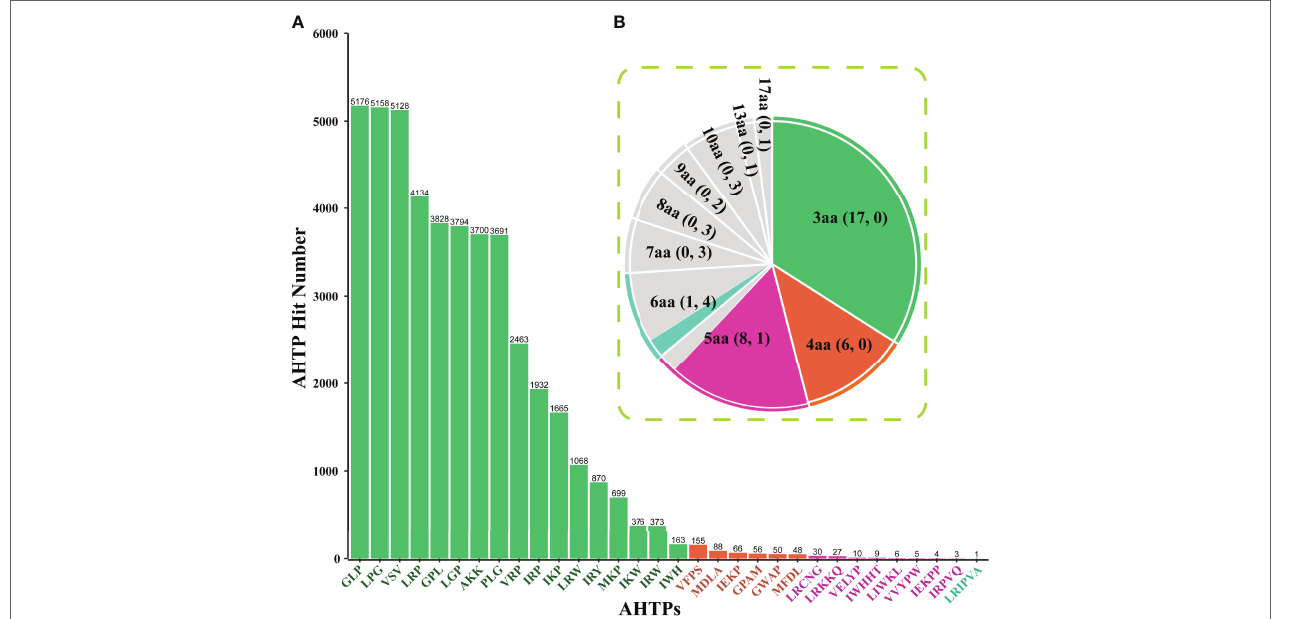
FIGURE 1 | Frequency distribution of AHTPs that were identified from the multi-omics datasets of the lined seahorse. (A) A bar chart for the detailed hit number of each putative AHTP. The x-axis represents the identified 32 AHTPs, and the y-axis stands for the corresponding number of each AHTP. (B) A pie chart for summary of AHTP hits with various length. Green, orange, pink, and aqua refer to AHTP groups consisting of three, four, five, and six amino acids (aa), respectively. Grey means no hits in the lined seahorse genome. The two numbers in every bracket refer to the identified AHTP types and the missing types in each group,